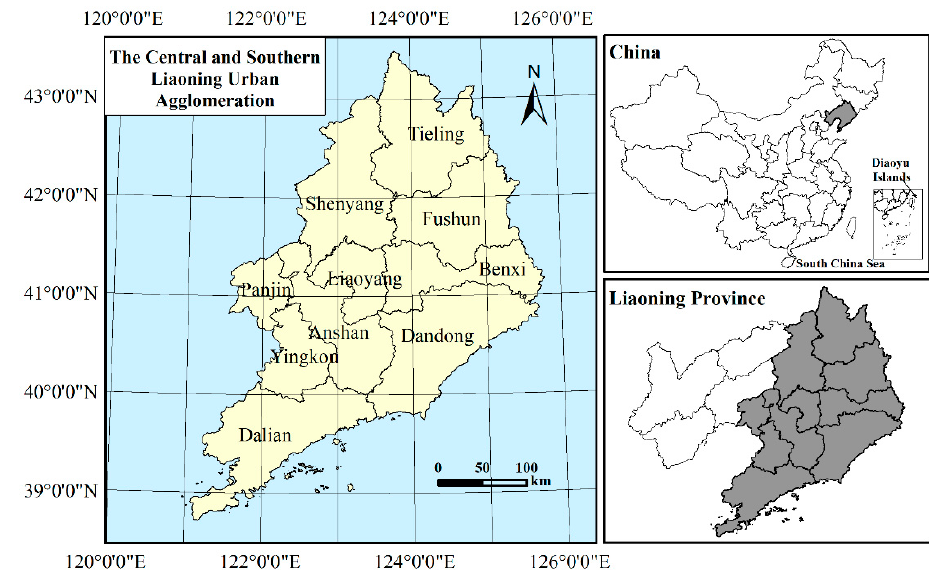
Figure 1. Location of the study area in Liaoning Province, China.